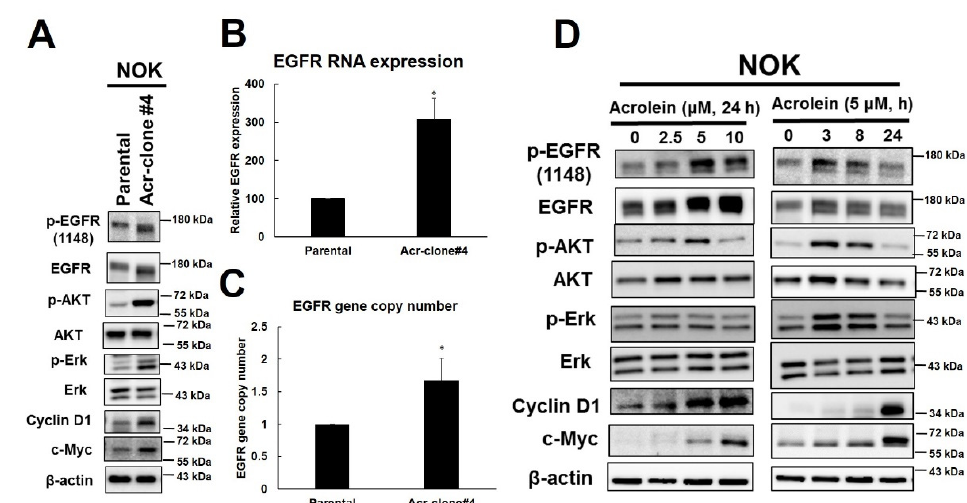
Figure 3. EGFR signaling pathway was activated in acrolein-transformed NOK clone #4 and acrolein treatment-induced activation of EGFR signaling pathway in parental NOK cells. ( A ) Western blot analysis of EGFR pathway (p-EGFR, EGFR p-AKT, AKT, p-ERK, ERK, cyclin D1, c-myc) in acrolein-transformed clone #4 compared to parental NOK cells. ( B ) mRNA expression of EGFR was analyzed in NOK Acr-clone #4 and NOK parental cells using quantitative real-time RT-PCR assays. ( C ) Gene copy number of EGFR was analyzed in NOK Acr-clone #4 and NOK parental cells using quantitative real-time PCR. Data was expressed relative to the LINE1 gene. Student’s t -tests were used to determine statistical significance, and two-tailed p -values are shown. * p < 0.05 compared with NOK parental cells. ( D ) Western blot analysis of EGFR pathway in NOK cells treated with acrolein in time- and dose-dependent manners.